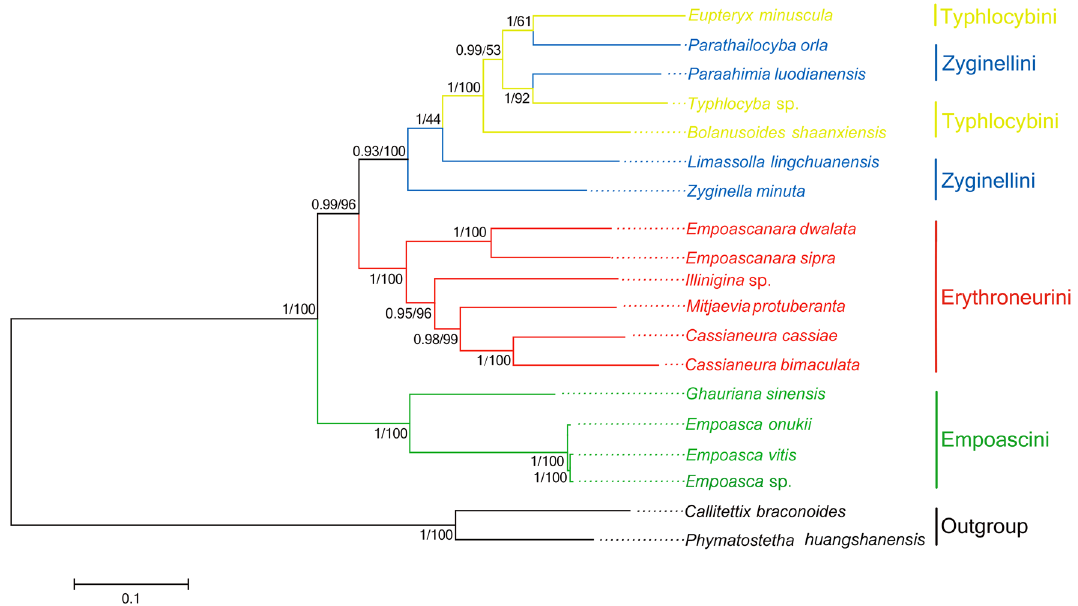
Figure 4. Phylogenetic tree from Typhlocybinae based on nucleotide sequence of 13 PCGs. Numbers above the nodes refer to the posterior probability (left) of Bayesian (BI) analyses and bootstrap proportion (right) of maximum likelihood (ML)